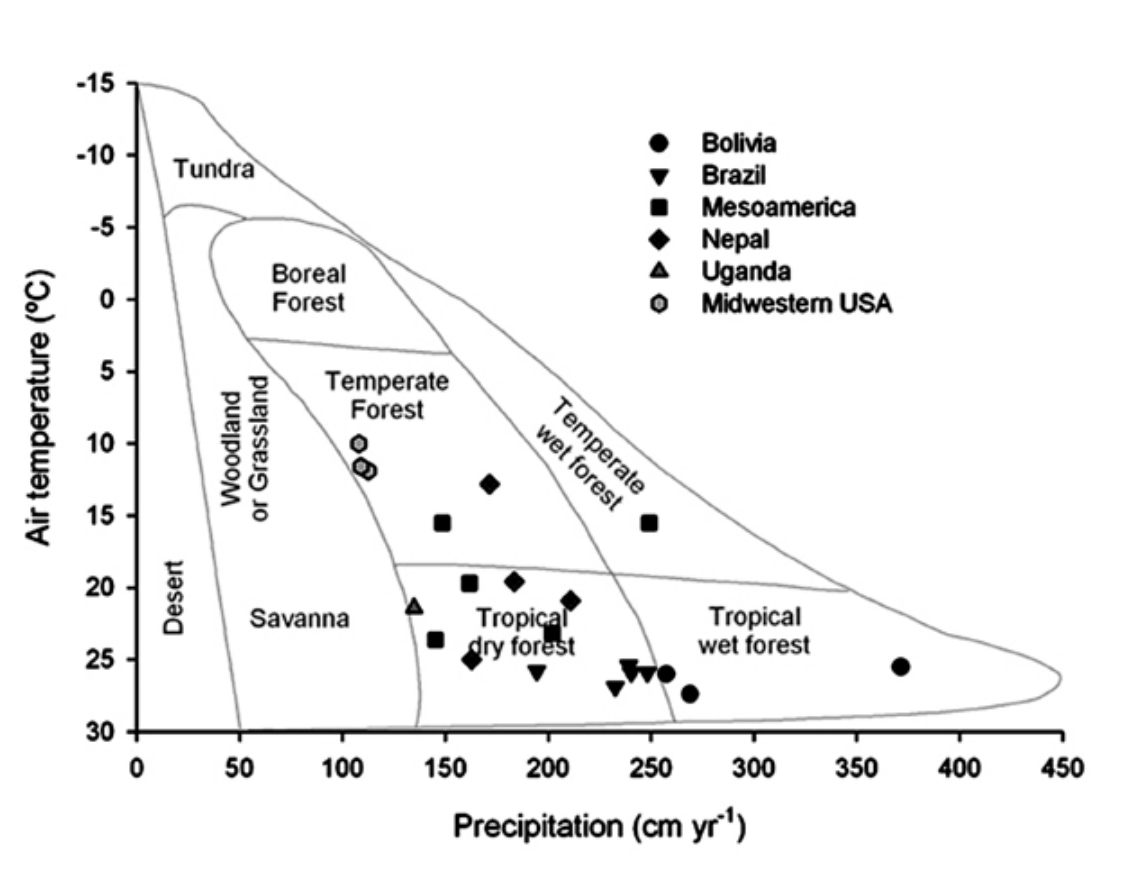
Fig. 1. Mean annual temperature and precipitation regimes of 42 forests in six regions. Because the climate may be quite similar in several forests within a region, several locations have highly overlapping symbols in this